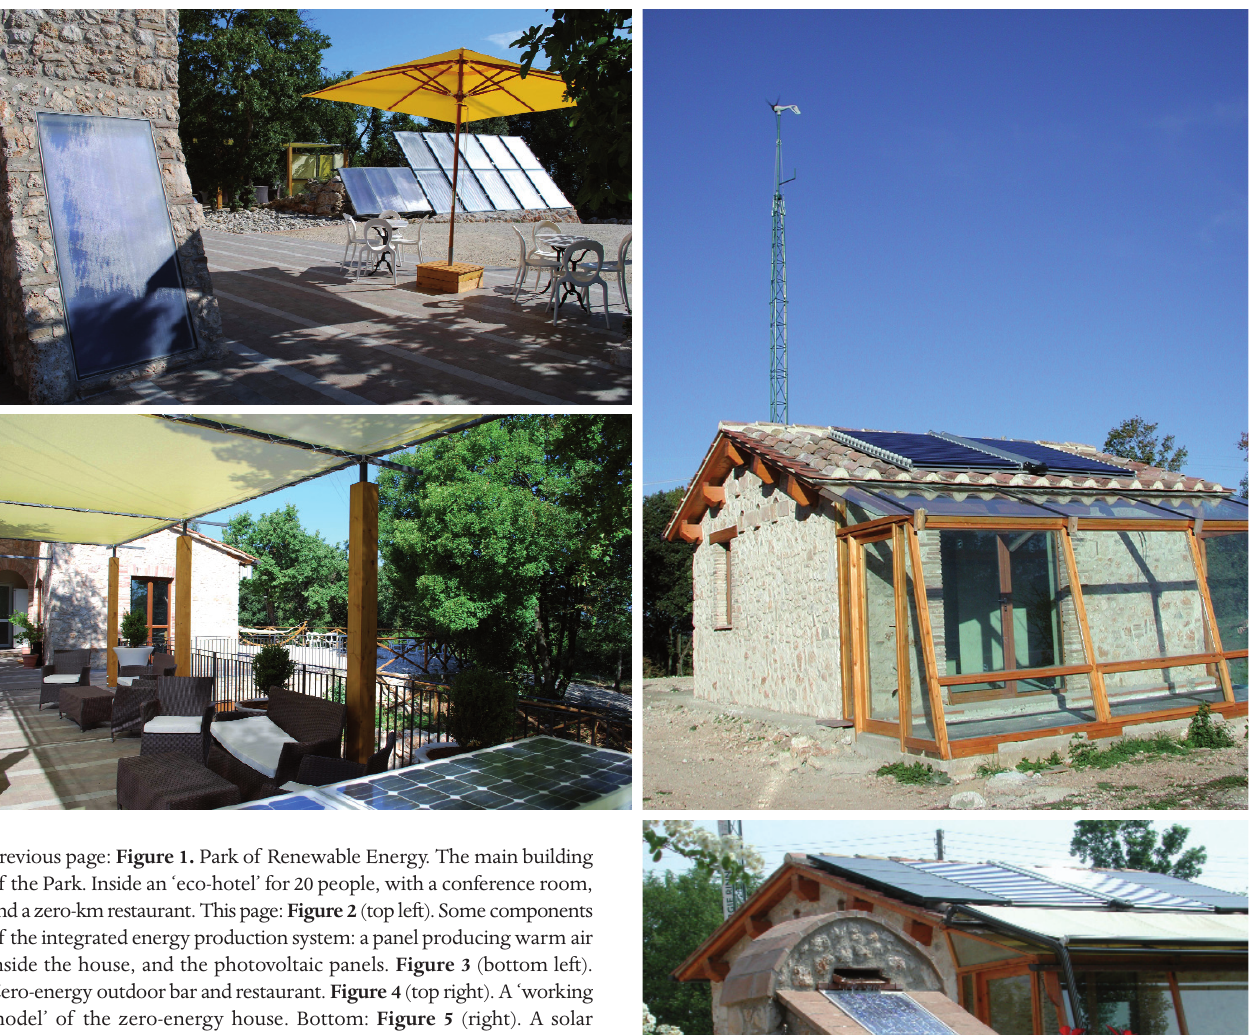
Previous page: Figure 1. Park of Renewable Energy. The main building of the Park. Inside an ‘eco-hotel’ for 20 people, with a conference room, and a zero-km restaurant. This page: Figure 2 (top left). Some components of the integrated energy production system: a panel producing warm air inside the house, and the photovoltaic panels. Figure 3 (bottom left). Zero-energy outdoor bar and restaurant. Figure 4 (top right). A ‘working model’ of the zero-energy house. Bottom: Figure 5 (right). A solar fountain with a photovoltaic panel that feeds the circulation of the water, refreshed as it passes over the surface of the same panel. (Photographs: PeR - Il Parco dell’Energia Rinnovabile © All rights